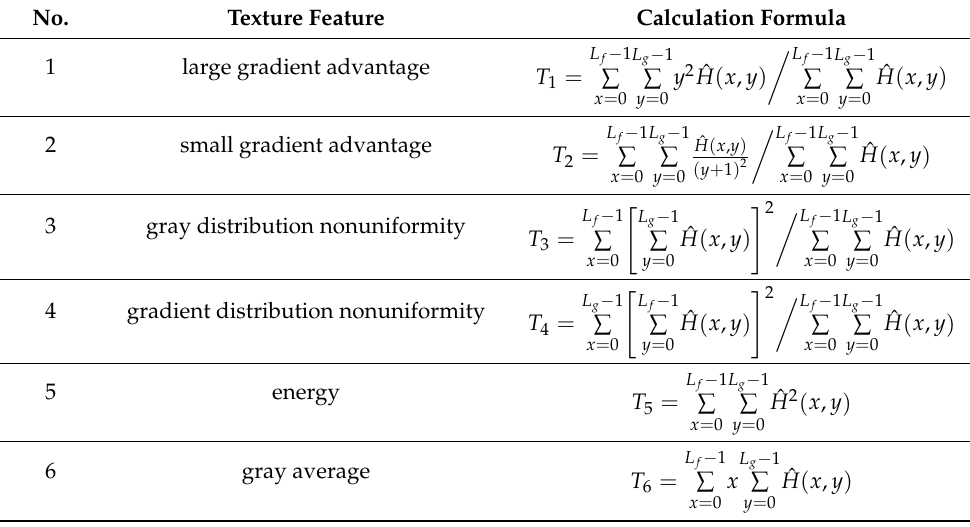
Table A1. The 15 grayscale gradient texture features and their calculation formulas.